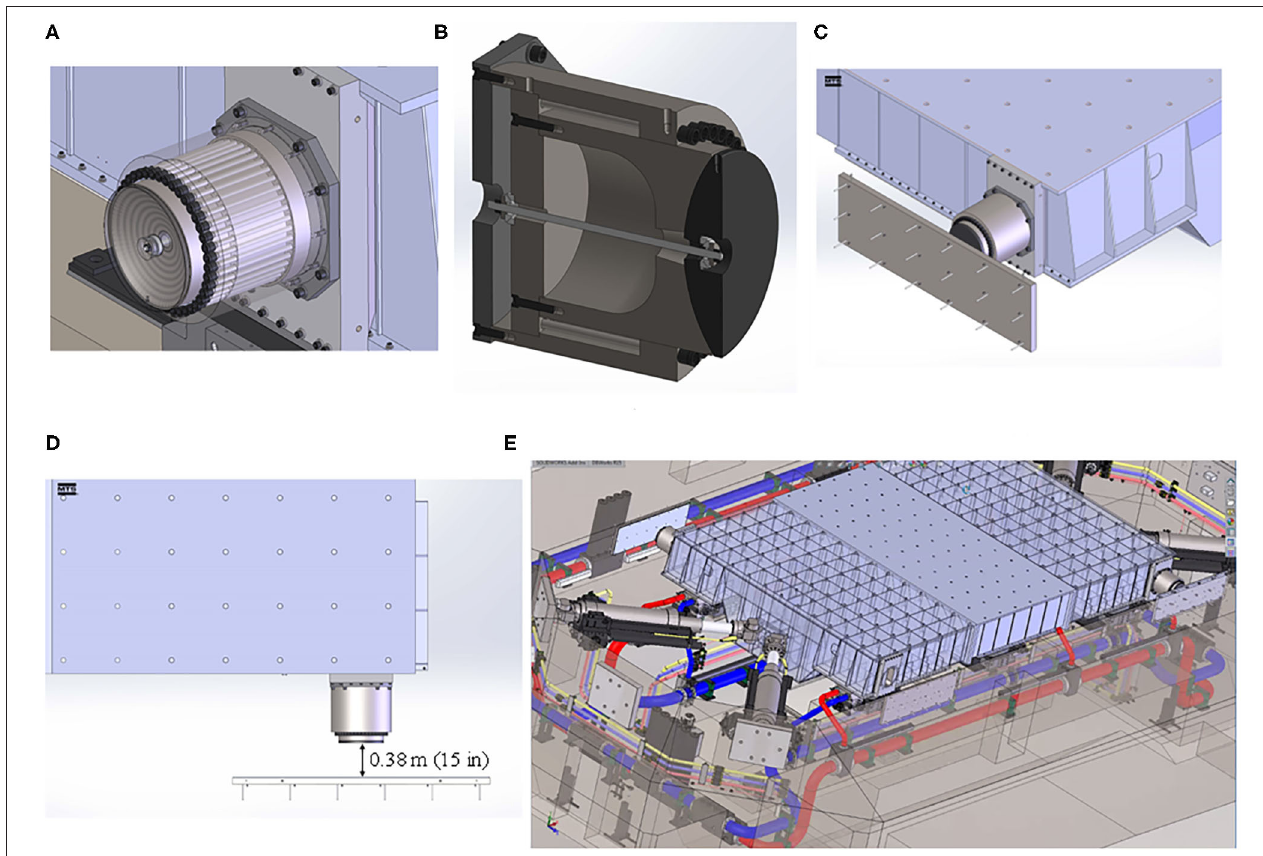
FIGURE 8 | Crash protection system: (A) view of 42 tensile rods, (B) internals of crash protection device, (C) crash protection device and impact plate, (D) distance between crash protection devices and impact plates, and (E) overall view of shake table platen and two of the crash protection devices.